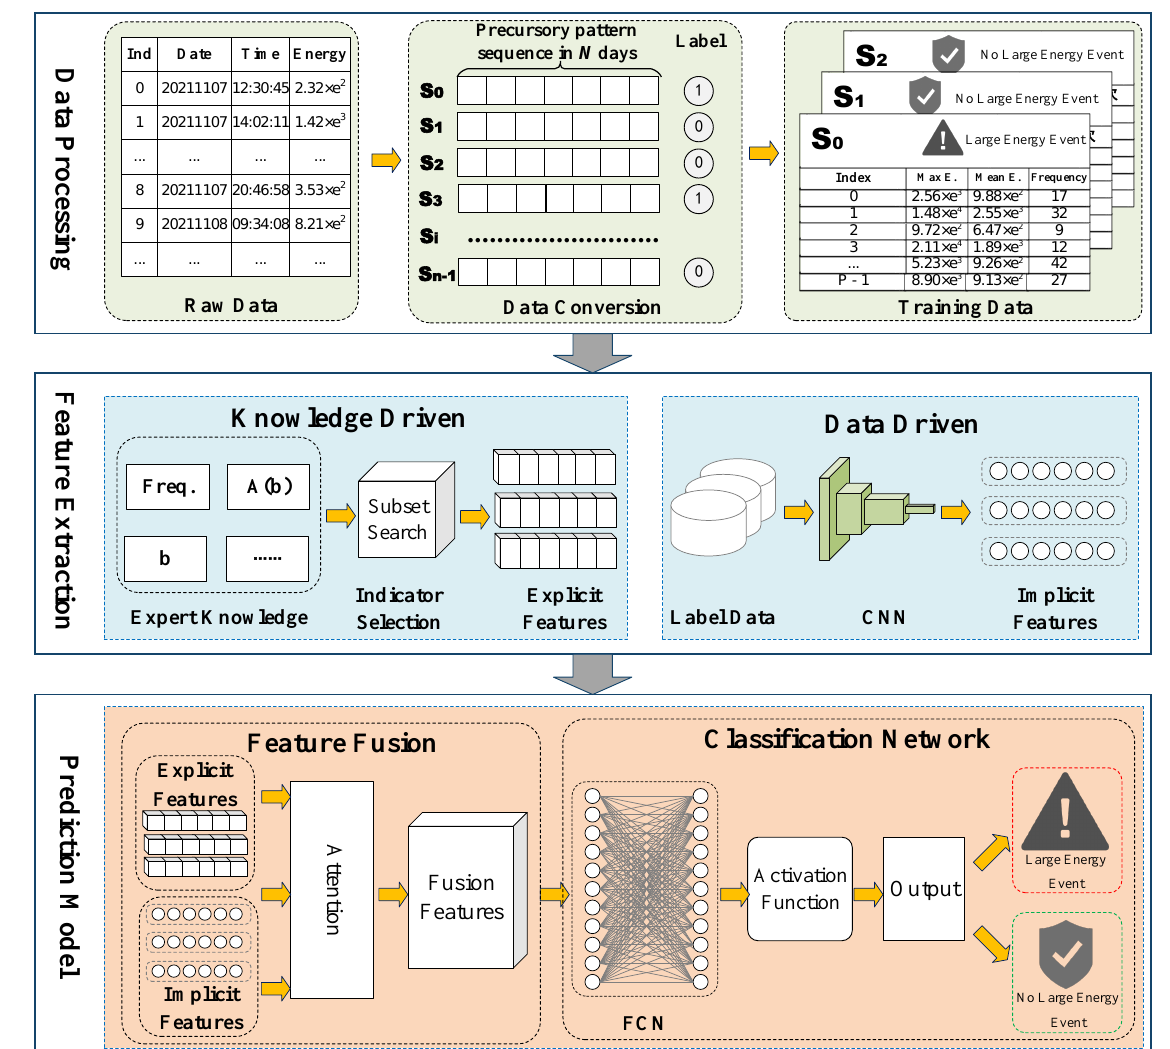
Figure 1. Knowledge and data fusion-driven deep neural network